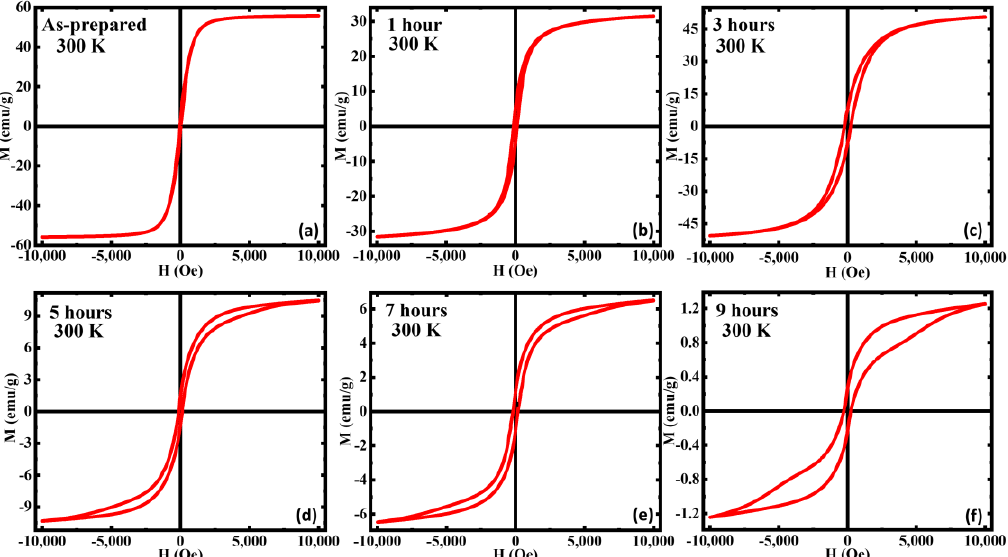
Figure 3. Magnetic hysteresis loops M(H) of ( a ) as-prepared, ( b ) annealed for 1 h, ( c ) annealed for 3 h, ( d ) annealed for 5 h, ( e ) annealed for 7 h, and ( f ) annealed for 9 h iron oxide nanorods at 300 K. For comparison, the M(H) data of ( a ) were taken from Ref. [33].